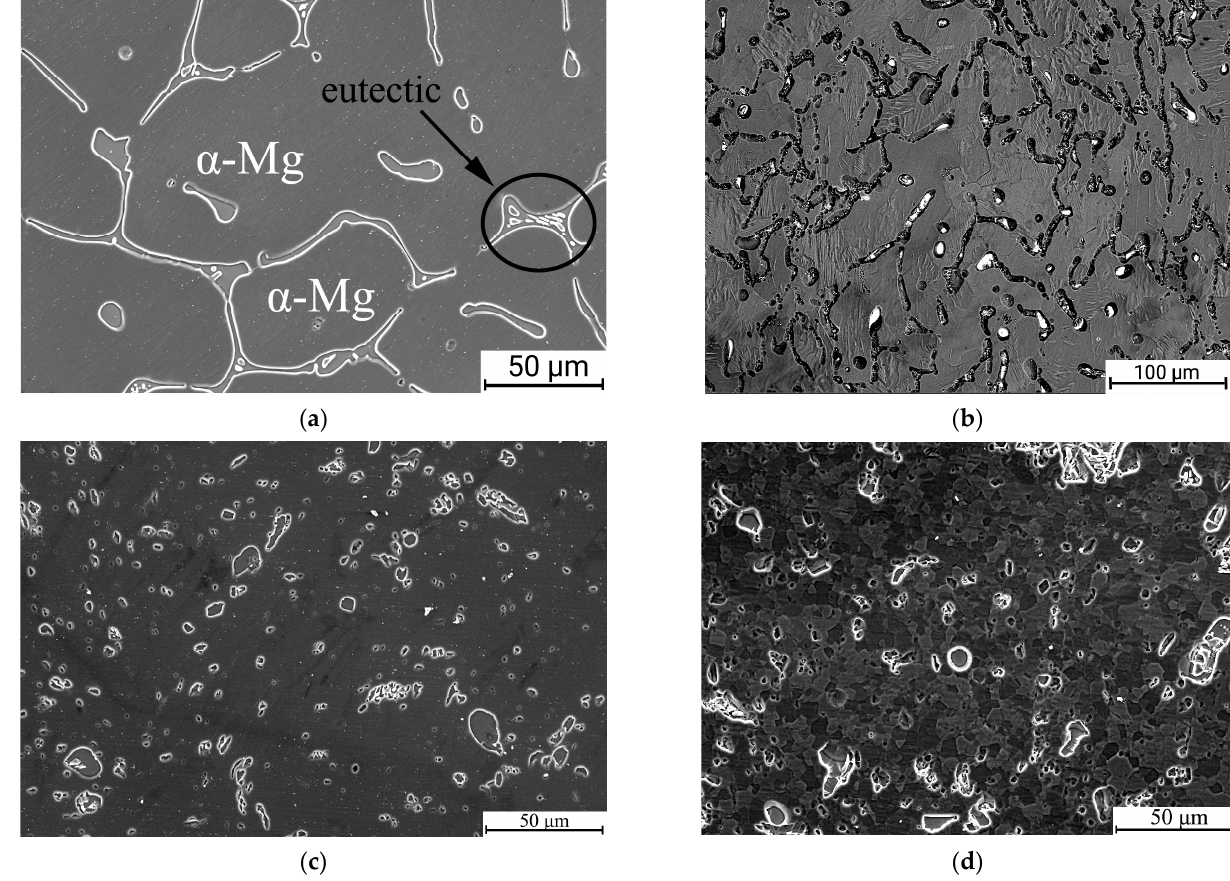
Figure 2. SEM images revealing microstructure of the Mg-2Sr alloy in the different states: initial ( a ); ECAP ( b ); cSPD ( c ) and cSPD-AA ( d ).